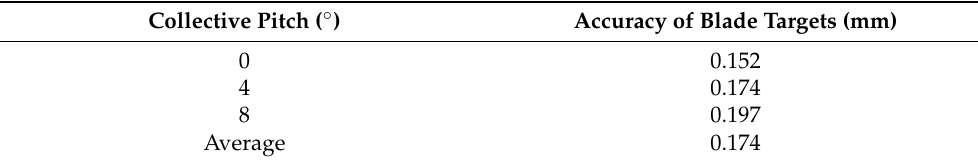
Table 1. Measurement